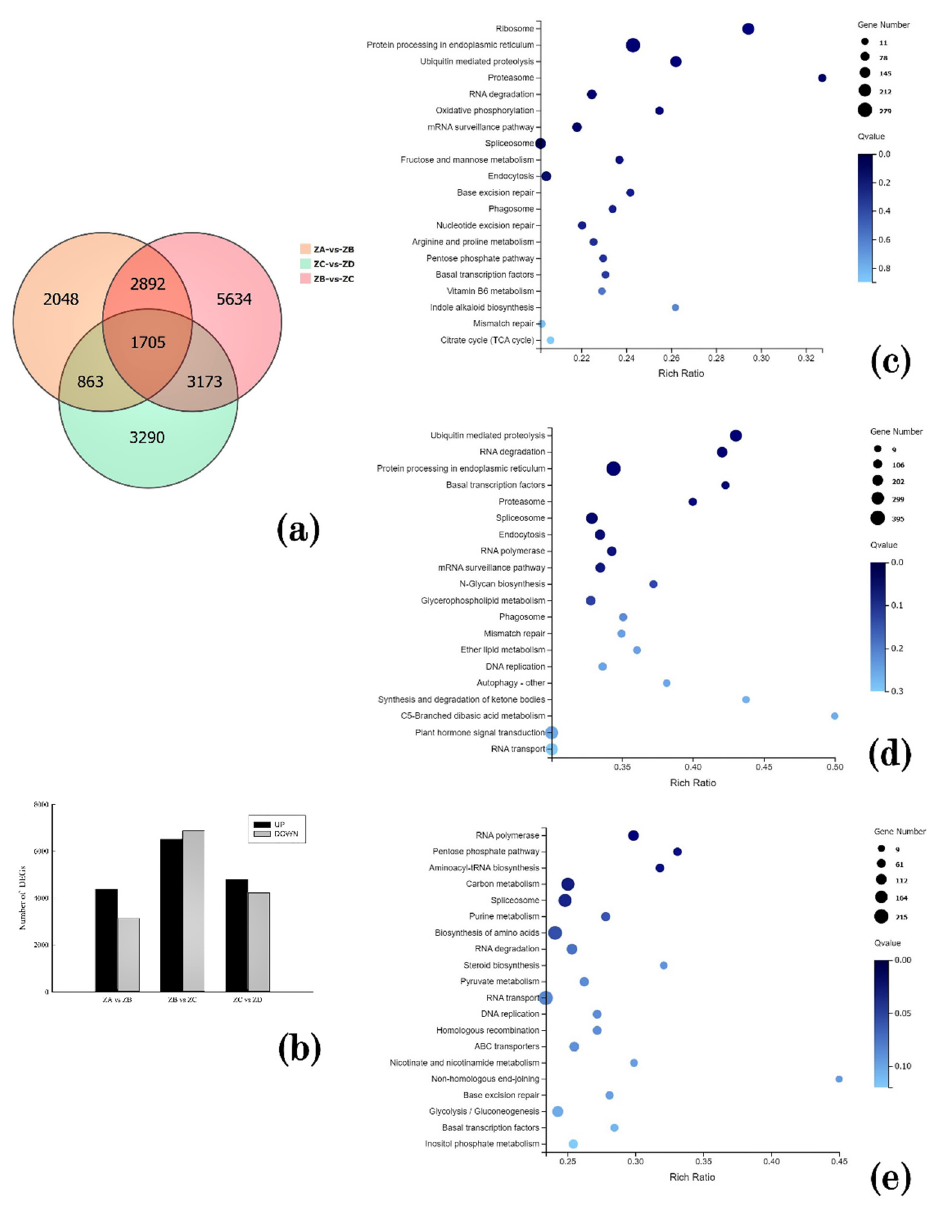
Figure 4. ( a ) Venn diagram of data of DEGs; ( b ) Statistical diagram of data of DEGs. ( c ) Statistical Diagram of Annotated Classification of DEGs of ZA vs. ZB. ( d ) Statistical Diagram of Annotated Classification of DEGs of ZB vs. ZC. ( e ) Statistical Diagram of Annotated Classification of DEGs of ZC vs.